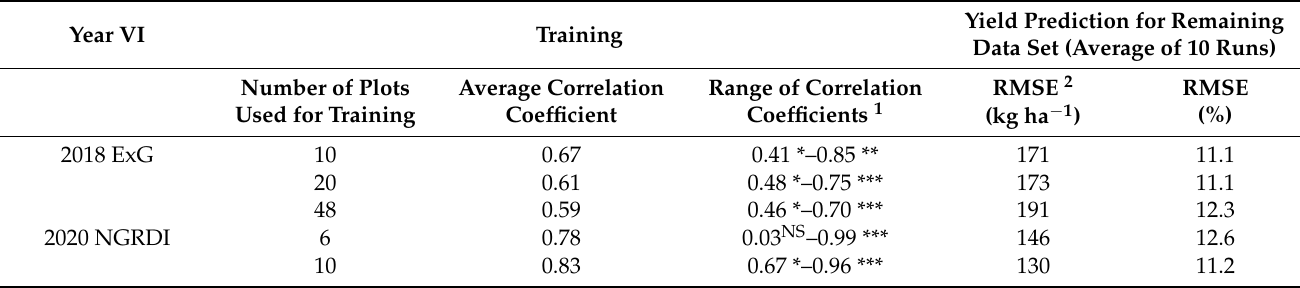
Table 2. Correlation between vegetation indices (VI) and yield in training data sets and yield predictions for the remaining part of the data sets. Random selection of data based on 10 random selections for each number of plots.